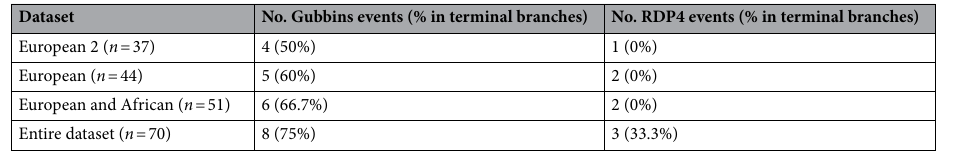
Table 2. Number of recombination events inferred by the Gubbins pipeline and RDP4.